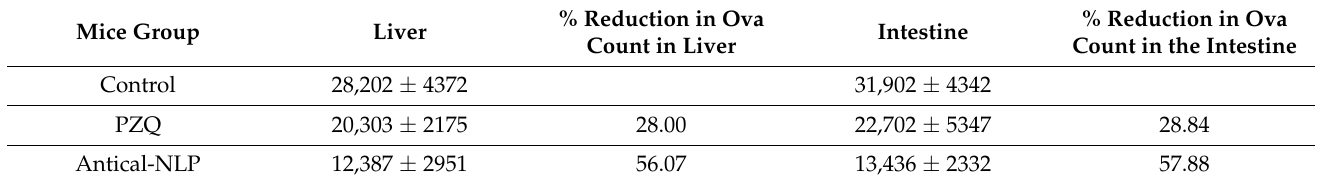
Table 2. Effect of PZQ and anti-calpain-NLP (single dose 250 mg/kg two weeks post infection) on number of ova/gm tissues in S. mansoni -infected mice sacrificed six weeks post